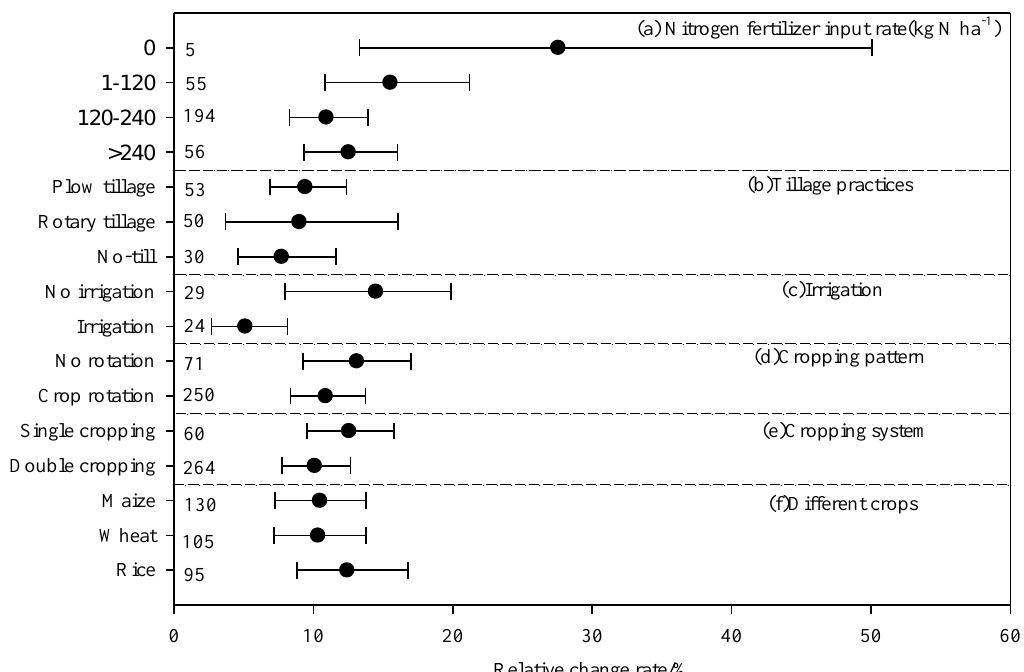
Figure 3. Relative change rate of SOC storage responding to residue retention under field management practices. Vertical axis represents invalid line, error bars represent 95% confidence intervals, the numbers to the right of the vertical axis are numbers of comparisons; if confidence intervals do not overlap with zero, it indicates significant increase (>0) or decrease (<0) ( p < 0.05).